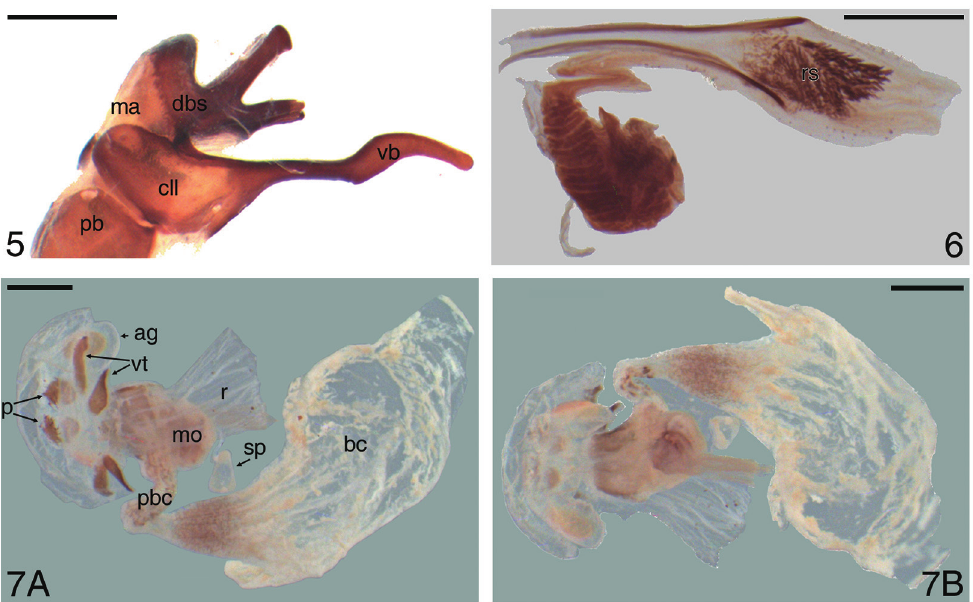
Figs 5–7. Morphotype II “ Gressitti ”. 5–6 . Male genitalia of Miridiba herteli (Frey, 1971), paratype (NHMB). 5 . Parameres in lateral view. 6 . Endophallus and temones in dorsal view. 7 . Female genitalia of M. gressitti (Frey, 1970), paratype (NHMB) in dorsal (A) and ventral (B) views. Scale bars = 1.0